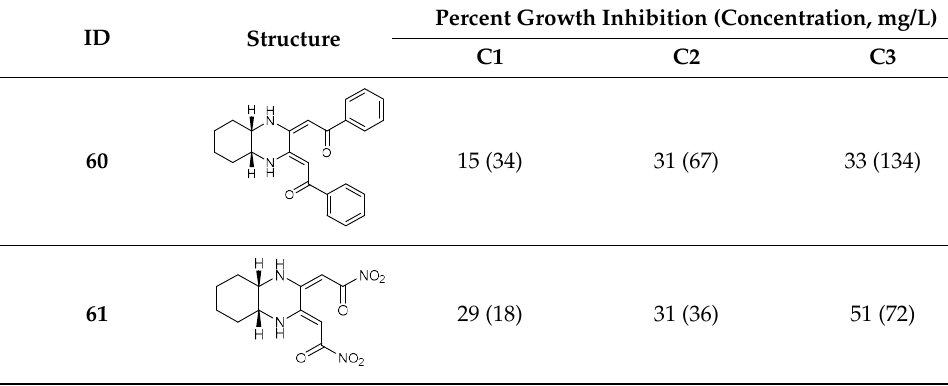
Percent Growth Inhibition (Concentration, mg/L)